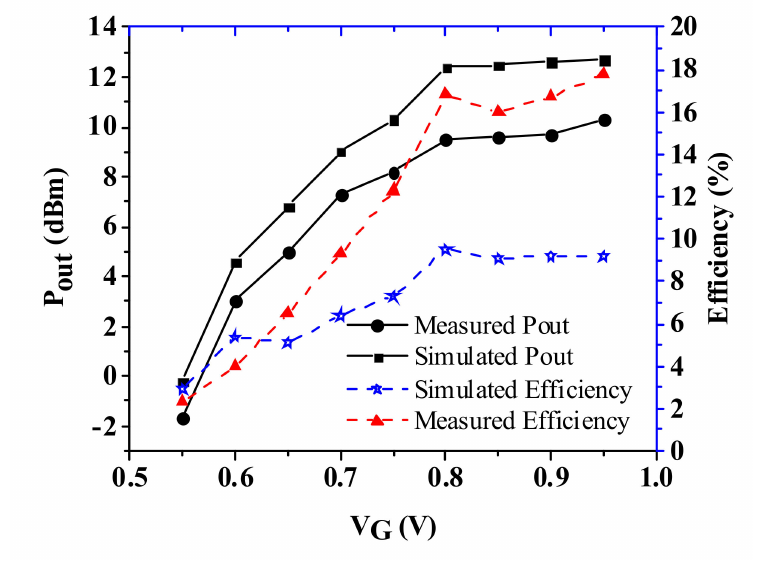
Figure 4. Measured output performance of